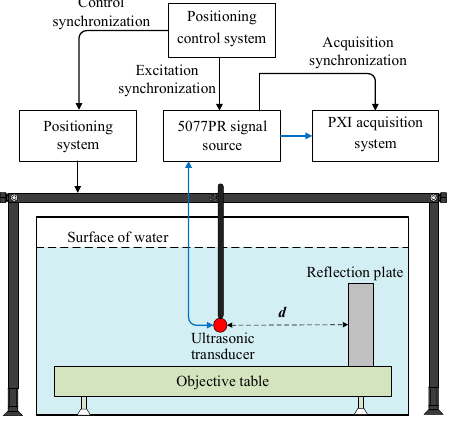
Figure 1. Schematic of the experimental equipment.